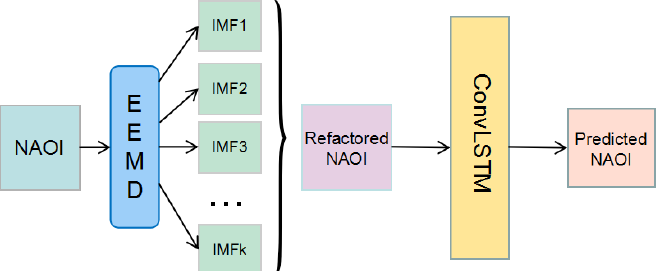
Figure 1. The architecture of the proposed method. IMF, Intrinsic Mode Function. NAOI, North Atlantic Oscillation index.